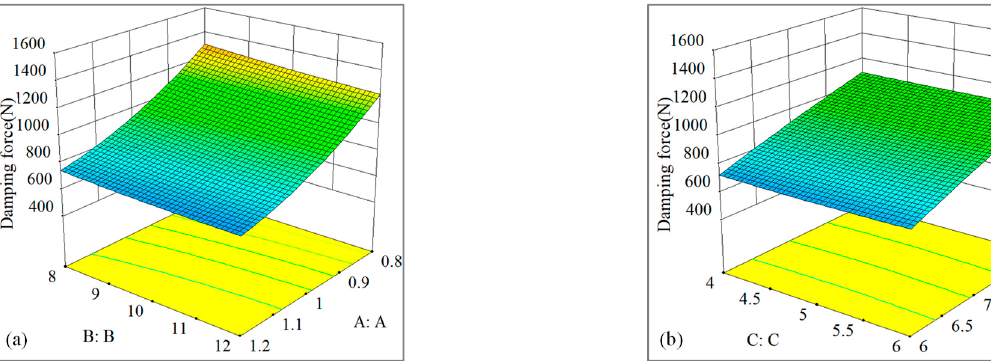
Figure 16. Relationship between damping force and design variables: ( a ) damping force F d vs. A and B; and ( b ) damping force F d vs. C and D.